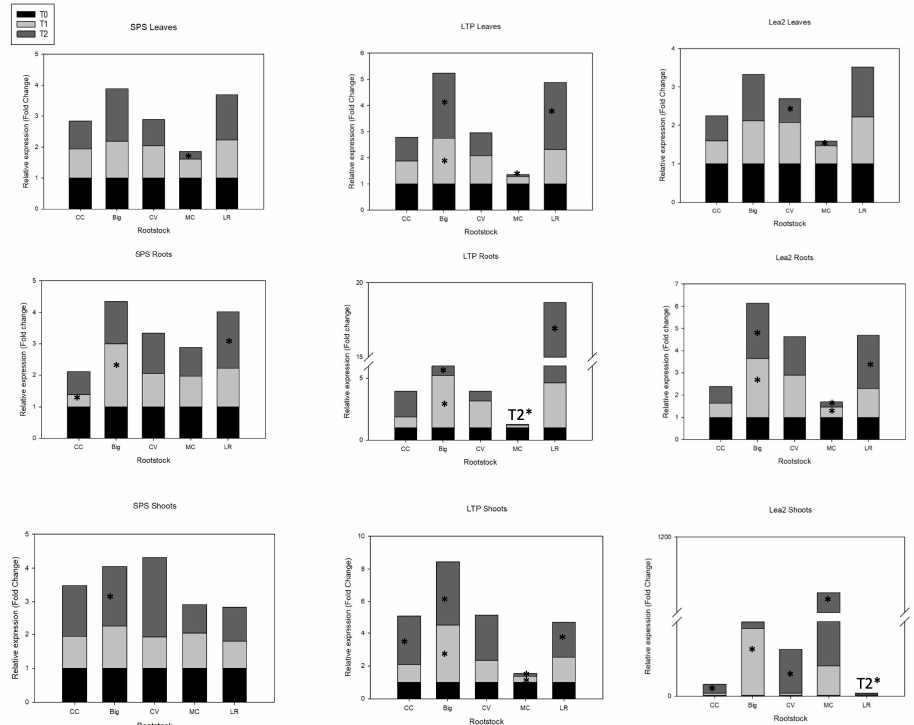
Figure 4. Expression profiles of SPS, LTP, and LEA2 genes in ‘Hernandina’ clementine ( Citrus clementina hort. ex Tanaka) (willowleaf mandarin ( C. deliciosa ) × sweet orange ( C. sinensis (L.) Osbeck)) grafted on 5 citrus rootstocks in response to salt. Big: sour orange ( C. aurantium L.); CC: Carrizo citrange ( C. sinensis × Poncirus trifoliata (L.) Raf); CV: Volkamer lemon ( C. volkameriana V. Ten. & Pasq.); LR: Rangpur lime ( C. limonia Osbeck); MC: Cleopatra mandarin ( Citrus reshni hort. ex Tanaka). For each combination (rootstock/’Hernandina’), stacked panels showed gene expression in plant tissues (leaves, shoots, and roots) treated with NaCl (T1: 35 mM NaCl; T2: 70 mM NaCl) relative to untreated samples (T 0 , only nutrient solution without salt treatment). Relative gene expression was calculated using 2 − ∆∆ CT method (fold change). * Significant differences for p values <